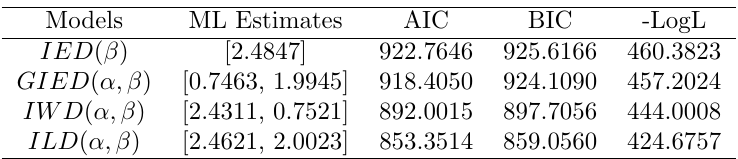
Values of different adaptive measures of model discrimination